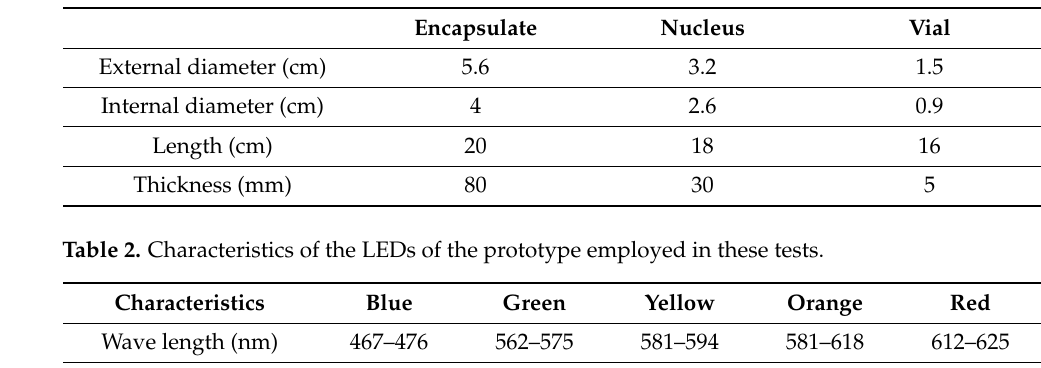
Figure 1. Representation of the used prototype: ( a ) Casing; ( b ) Prototype; ( c ) Sample vial; and ( d ) Position of LEDs and LDRs. Table 1. Dimensions of each section of the prototype.